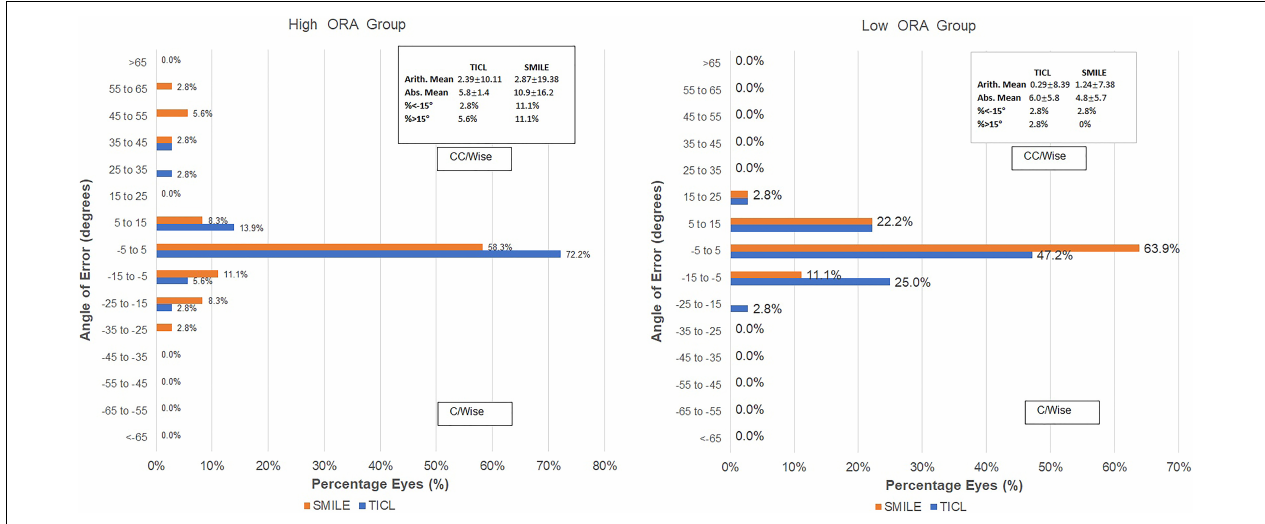
FIGURE 6 | Distribution of angle of error (AOE) after small incision lenticule extraction (SMILE) and toric implantable Collamer lens (TICL) implantation (Visian Implantable Collamer Lens; STAAR Surgical, Monrovia, CA, United States) for the high and low ORA